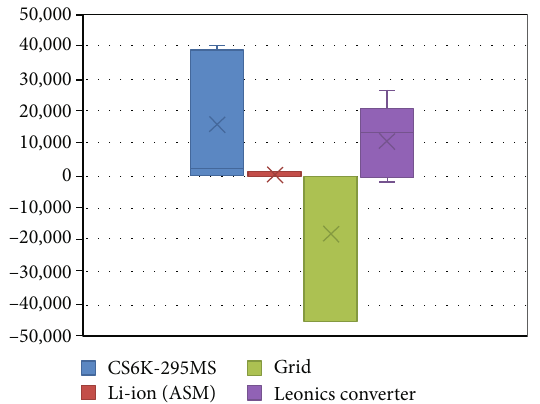
Figure 7: Cost summary (US$) results for PV (CS6K-295MS), battery (Li-ion), grid, and converter system.